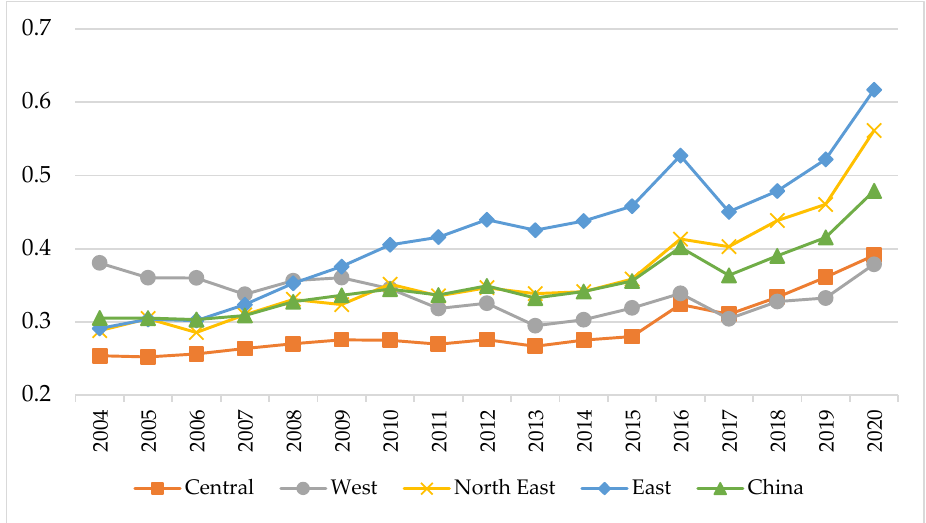
Figure 2. Trends of land resource use efficiency by region in China from 2004 to 2020.